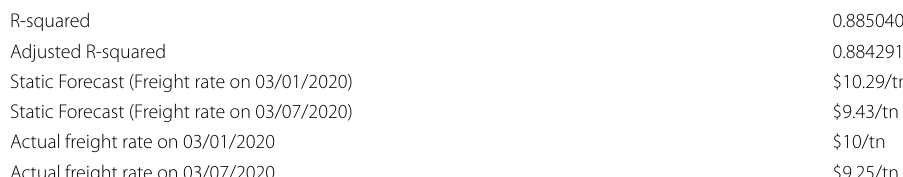
Table 1 Kamsar–San ciprian bauxite. Source : Elaboration by the authors